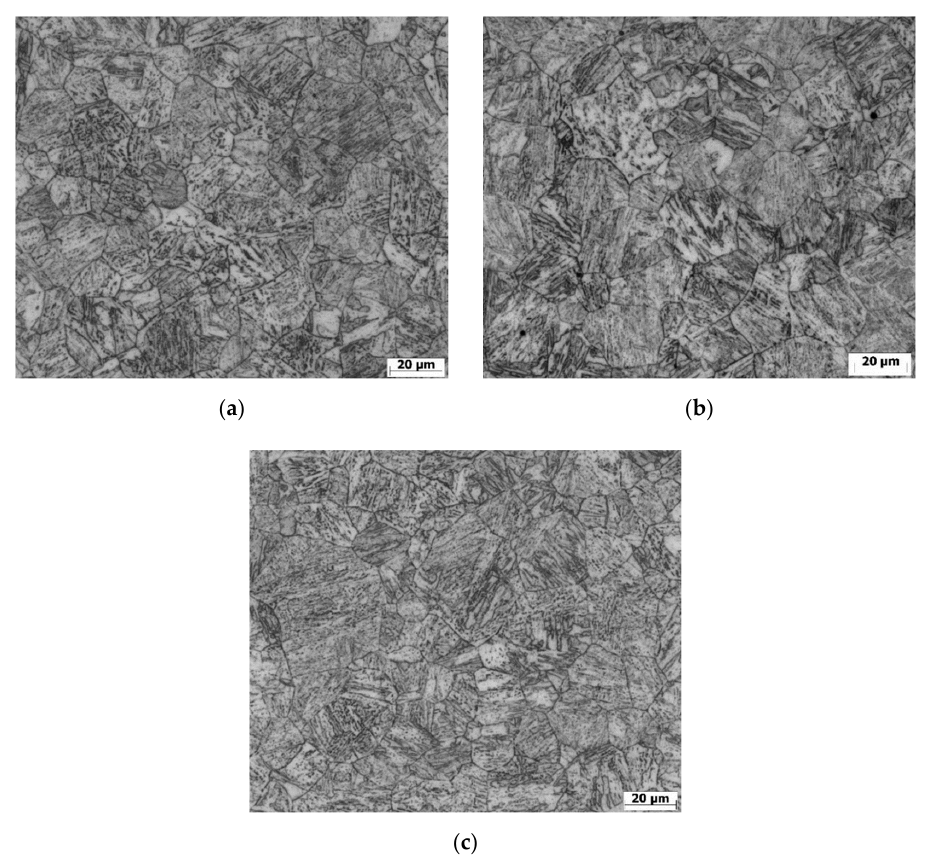
Figure 15. Microstructure in the center of the sample with different cooling times: ( a ) t 8/5 = 7 s; ( b ) t 8/5 = 10 s; ( c ) t 8/5 = 17 s.